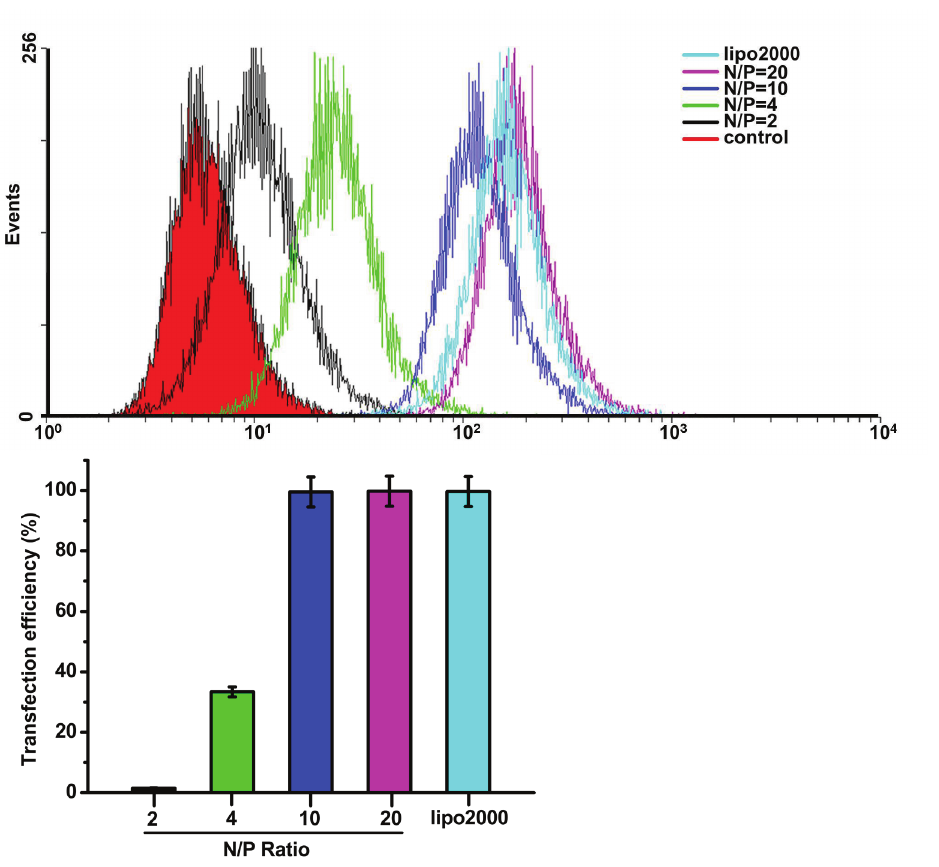
Figure 5: (a) The ratio of Cy3-positivexcells investigated by flow cytometry (n=3). Incubation time: 6 h. Dose: 100 nM miRNAs. (b) The transfection efficiencies varied at different N/P